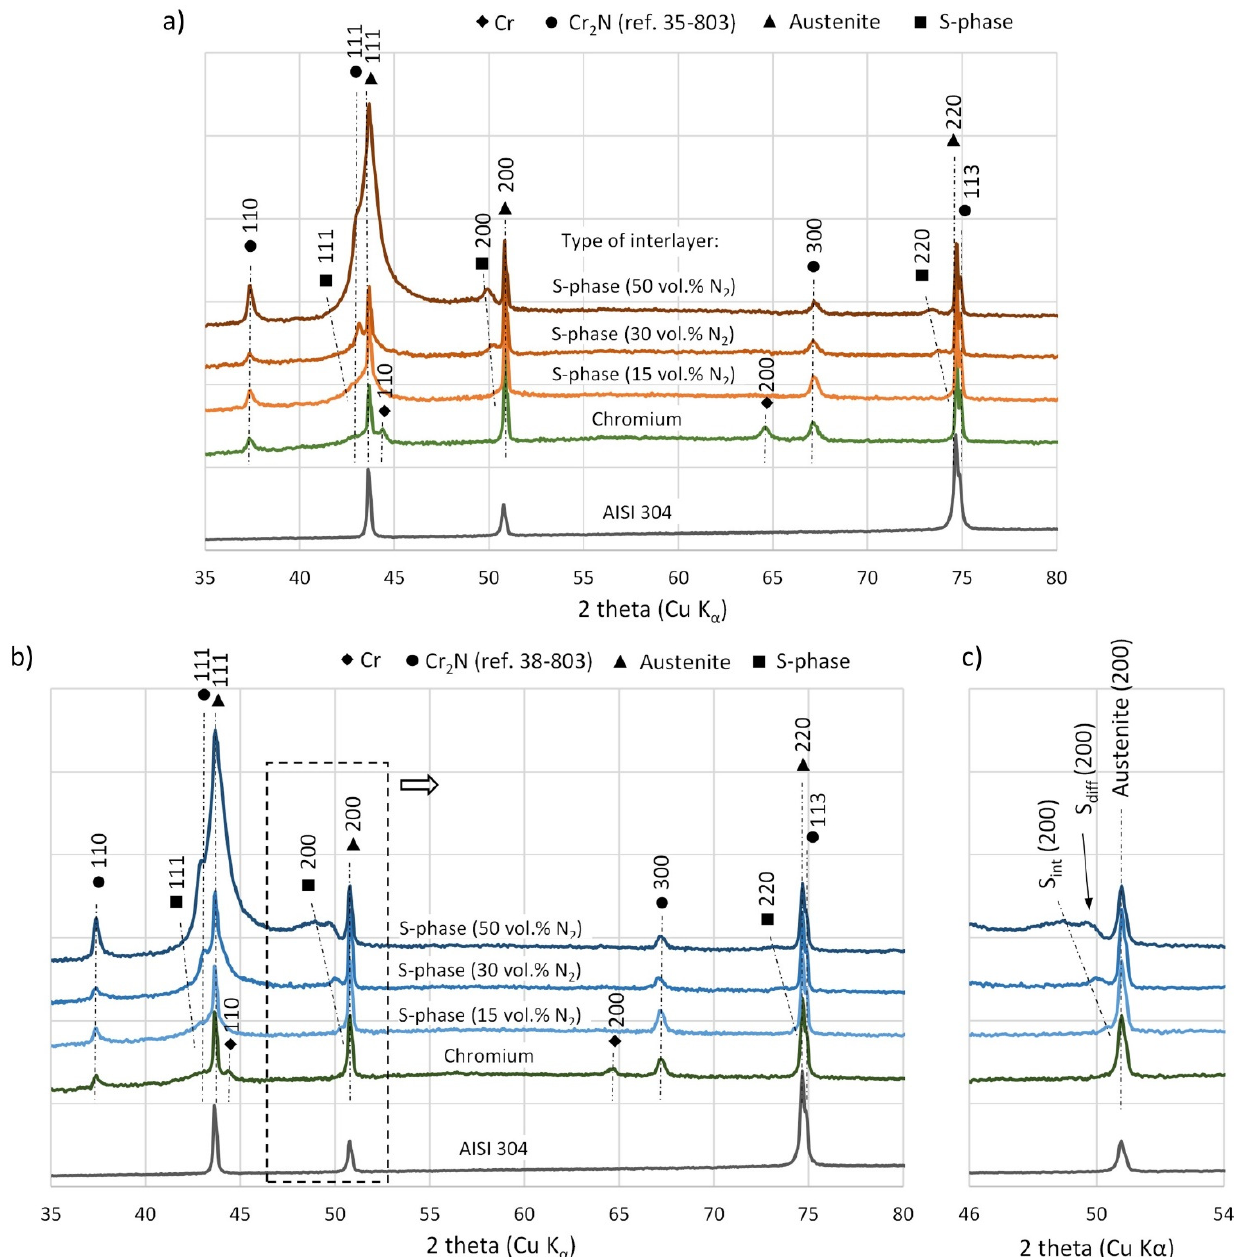
Figure 4. Diffraction patterns of the composite coatings deposited on: ( a ) as delivered substrates, ( b ) polished substrates, ( c ) diffraction peaks for crystallographic planes (200) marked on ( b ); XRD Cu K α ; S int —S-phase interlayer, S diff —S-phase diffusion layer.